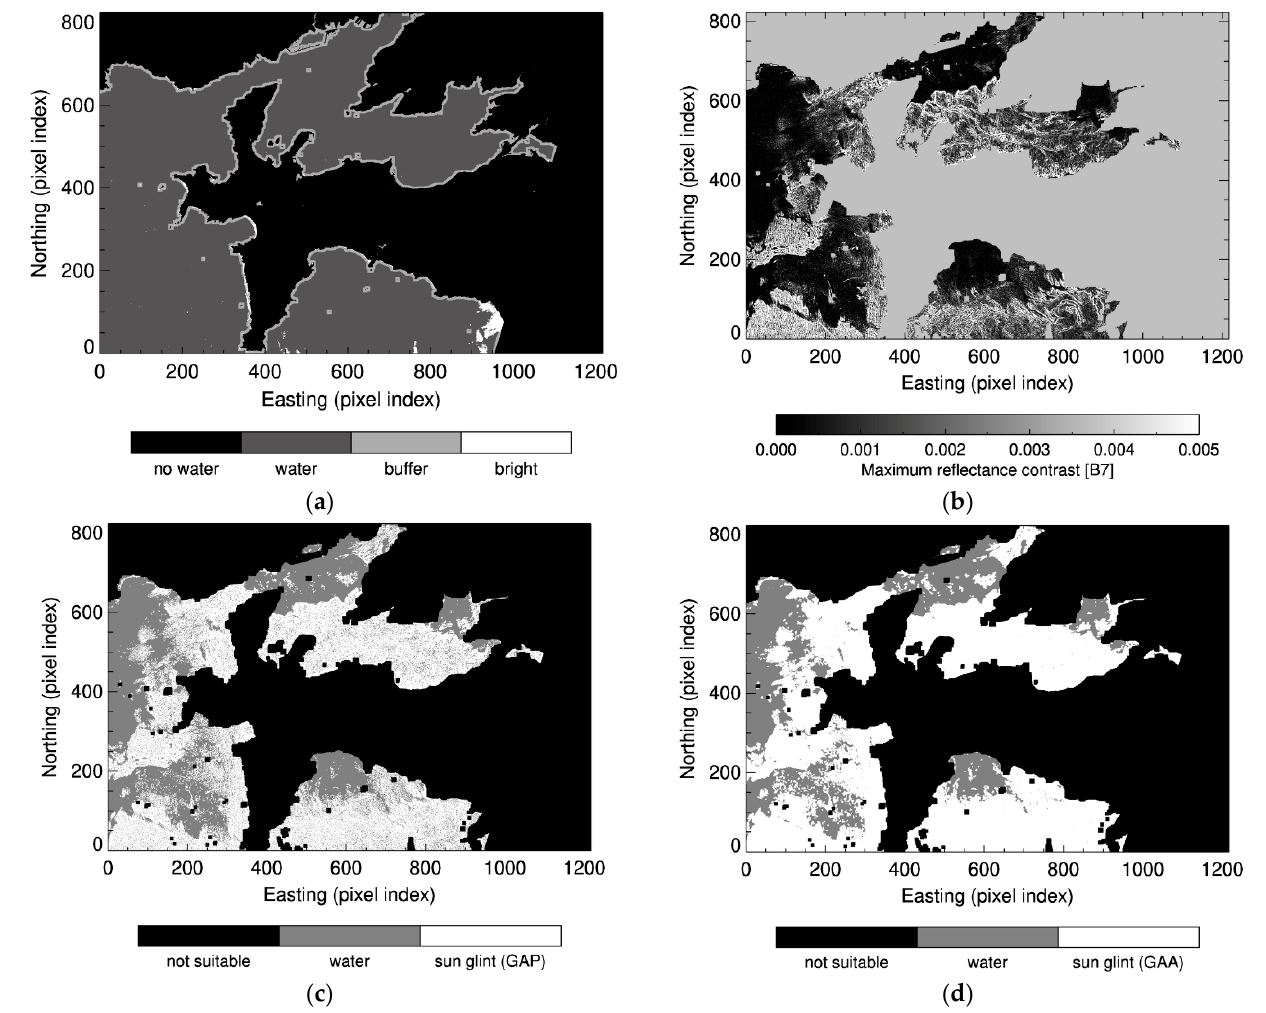
Figure 5. Determining the extension of the glint affected area (GAA) at the example of sample scene BRS-3. ( a ) Identification of pixels suitable for use in GRCM; ( b ) TOA MRC for OLI channel B7; ( c ) Glint affected pixels (GAP); ( d ) GAA. See text for further explanation.